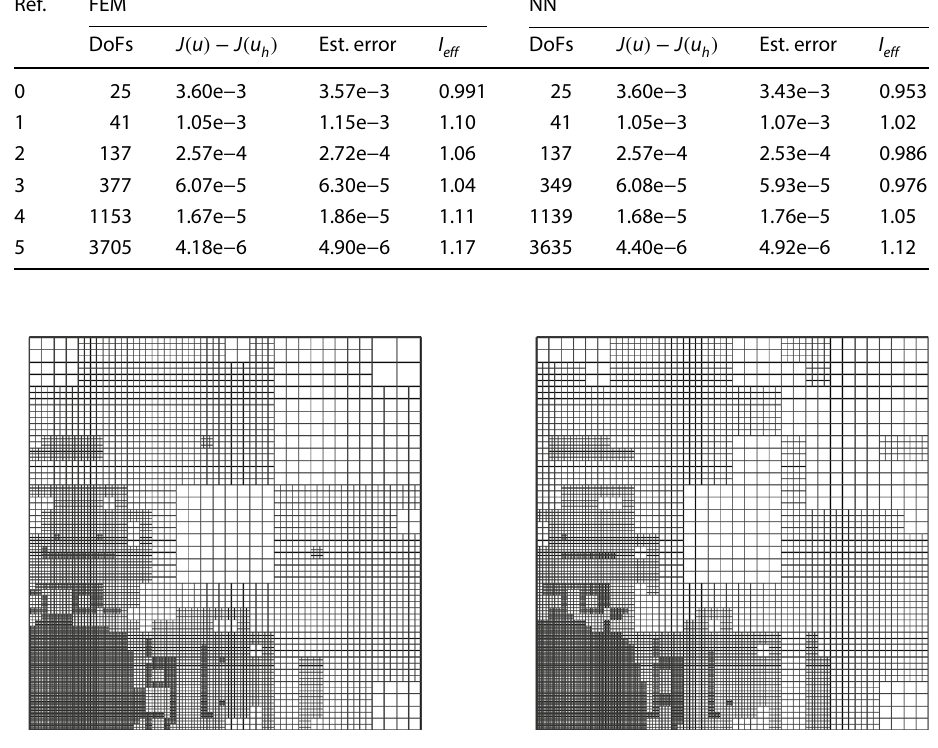
Table 2 Section 5.1.2: Error estimator results for regional mean value goal functional